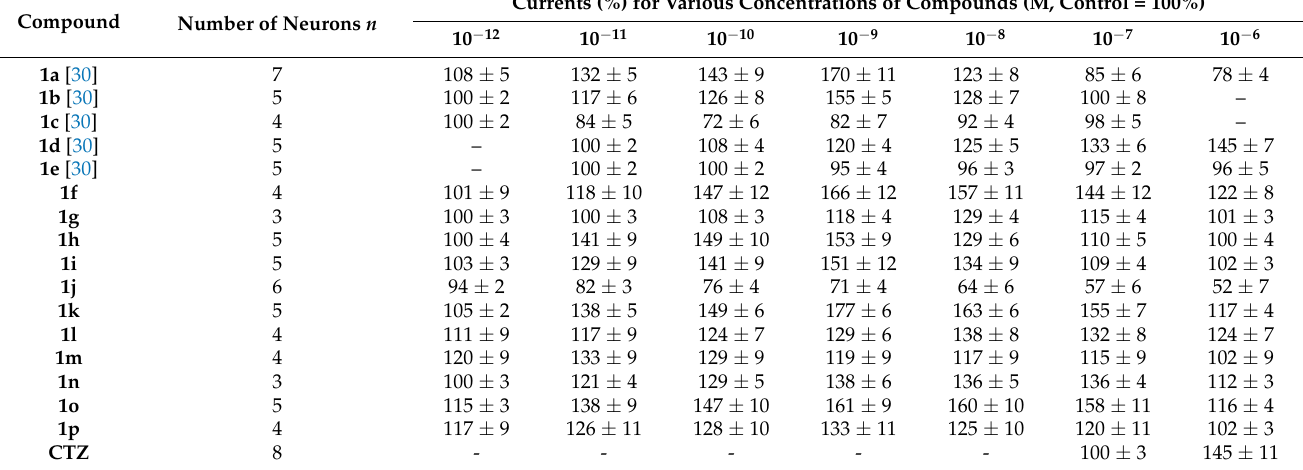
Table 1. The changes in the kainate ‐ induced Purkinje cell currents upon treatment with com ‐ pounds 1a–p .